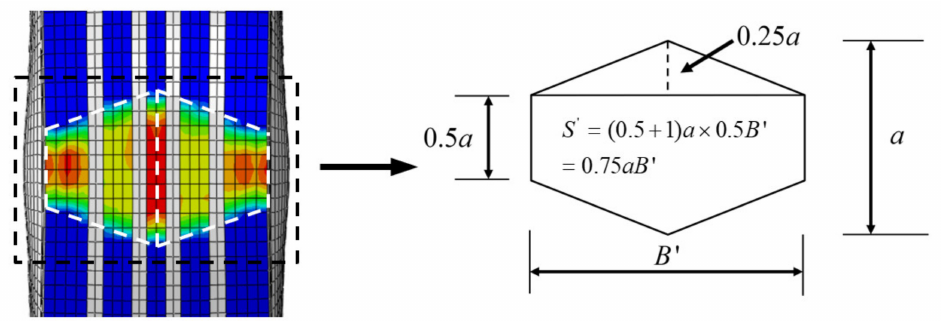
Figure 11. Calculation of passenger car tire